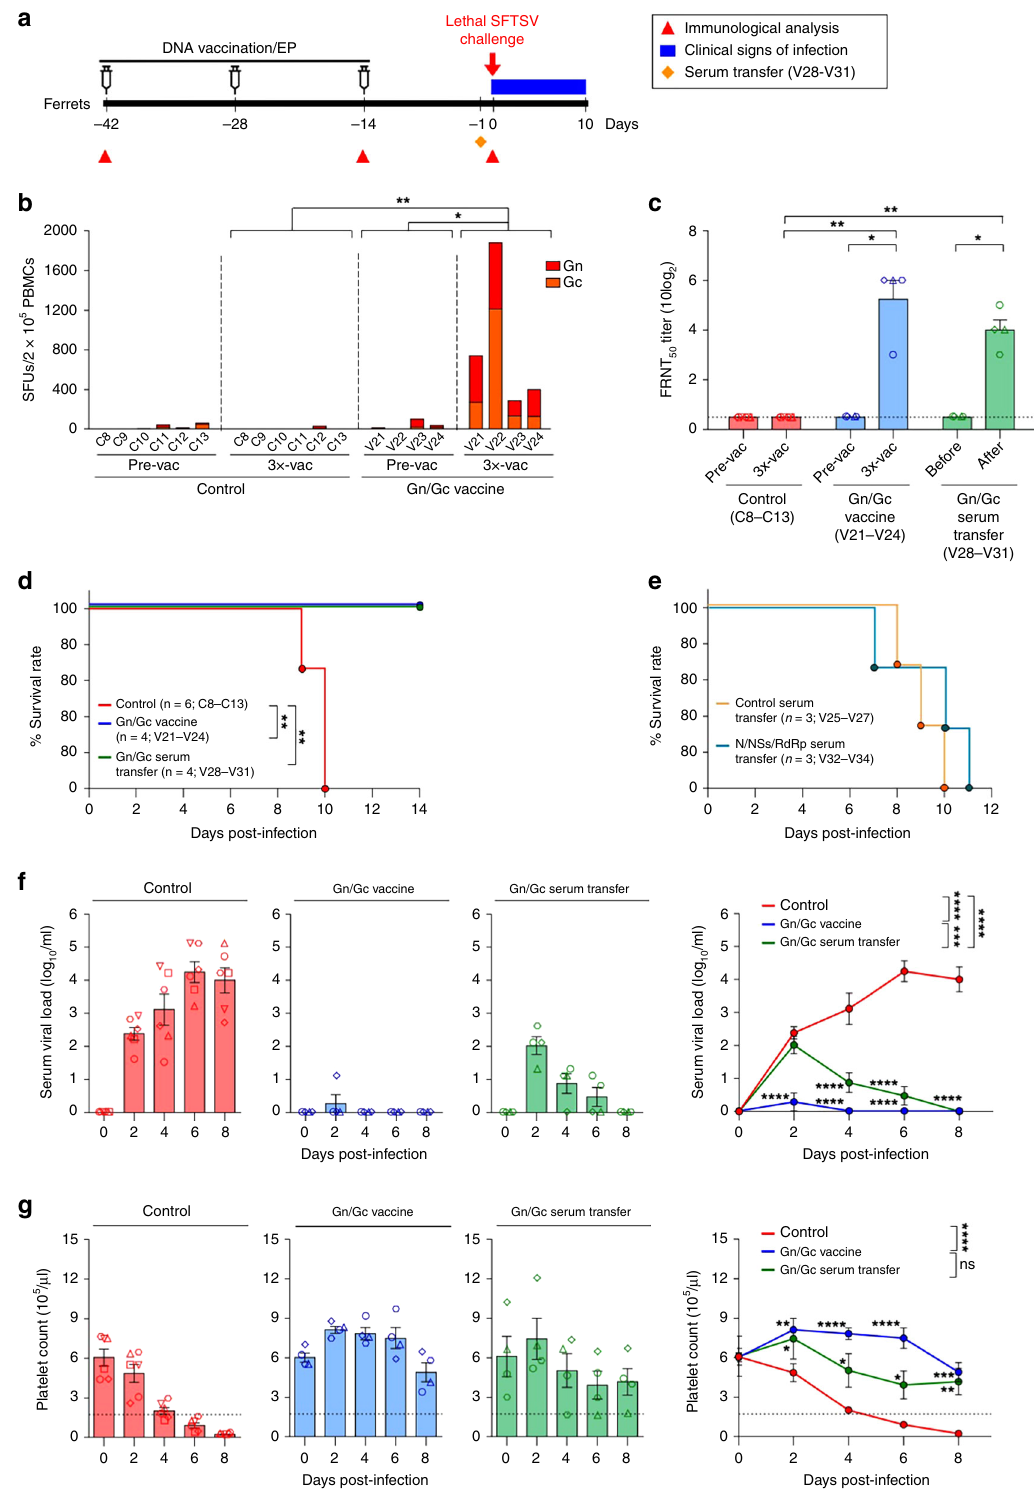
SFTSV challenge (Fig. 3f – g, blue bars (symbols) and lines, p < Gc-speci fi c immune responses played a critical role in protection 0.0001 and p < 0.0001, respectively (Gn/Gc vaccine vs. control, against lethal SFTSV infection. repeated-measures ANOVA)). Moreover, these vaccinated ferrets To speci fi cally investigate the role of the anti-envelope showed no other clinical signs of infection, including WBC antibody response as a protective immunity against SFTSV counts, body temperature, body weight, and ALT/AST levels infection, sera from Gn/Gc-vaccinated ferrets (S3-S4, Supple- (Supplementary Fig. 7). These results suggest that Gn- and mentary Fig. 8) were collected after three rounds of vaccination NATURE COMMUNICATIONS| (2019) 10:3836